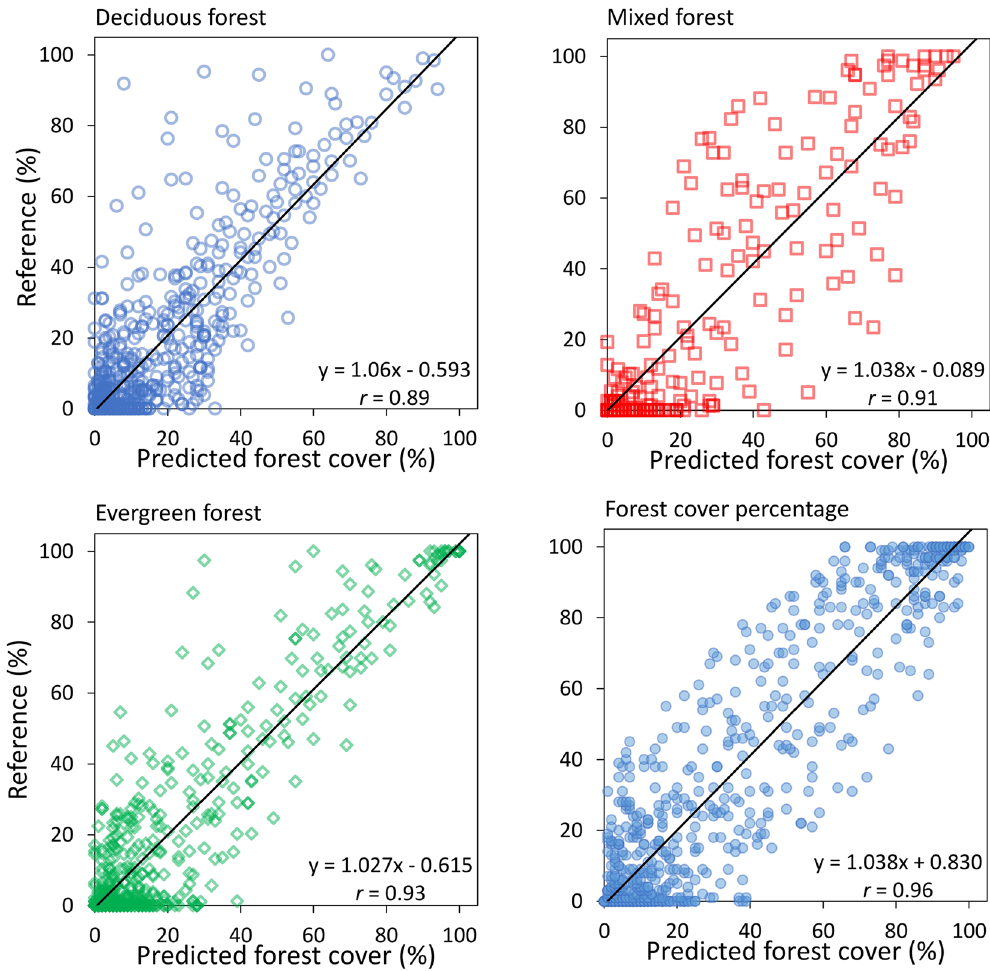
Figure 3. Scatterplots of reference forest cover derived from Landsat land cover maps and the estimated forest cover from MODIS data as deciduous, mixed, evergreen, and overall